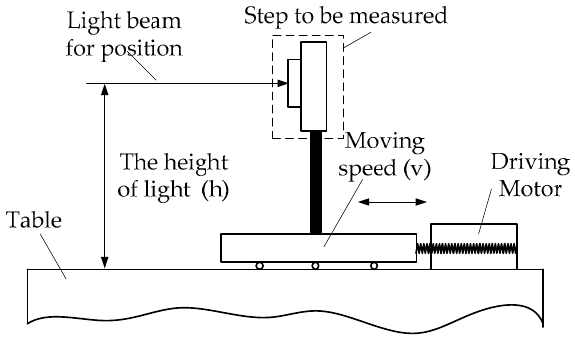
Figure 6. The layout of positioning unit.